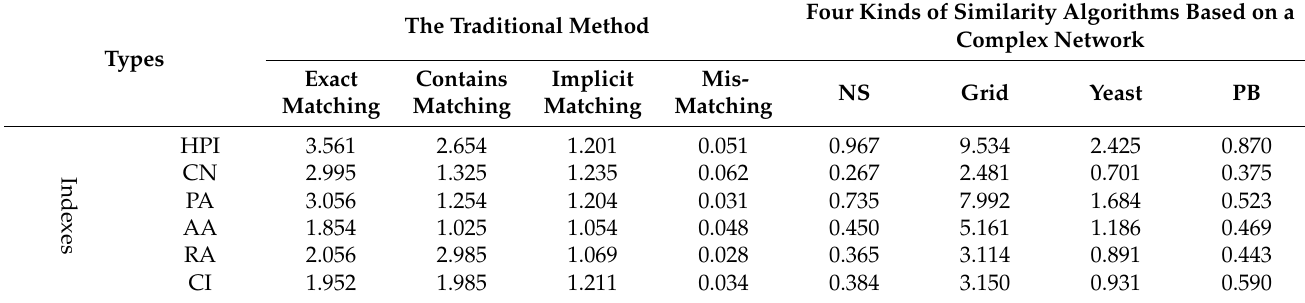
Table 5. The resulting AUC values (%) of the traditional method and 4 kinds of similarity algorithm based on a complex network.